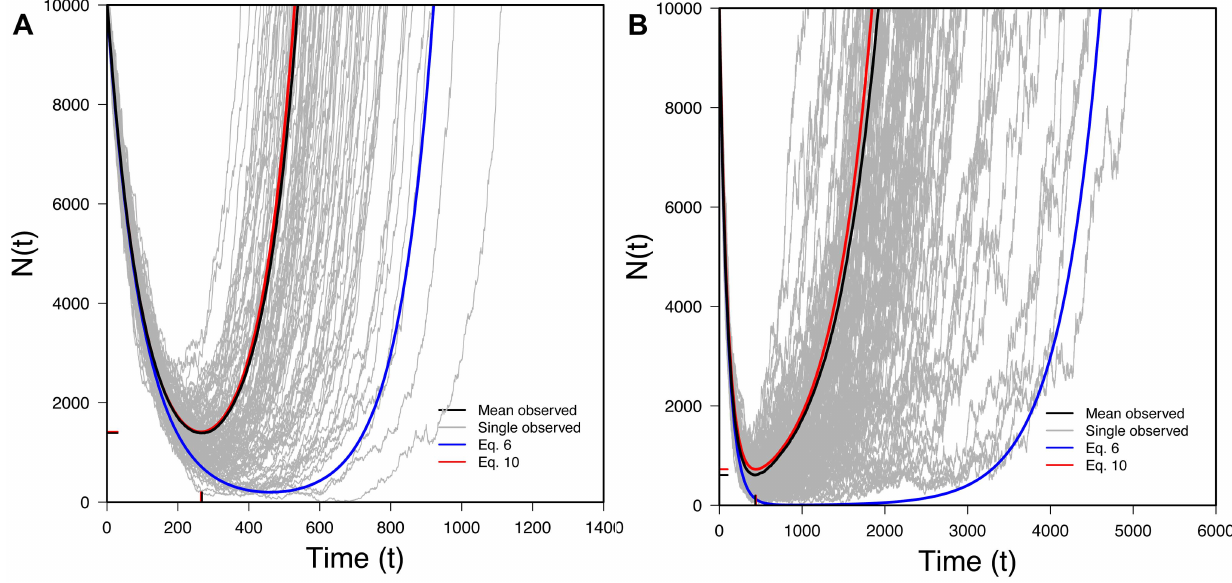
Figure 3. The U-shaped trajectory for populations rescued from standing variation. 100 randomly selected successful realizations in gray, mean of all successful realizations in black, Eq. 6 (without the oversampling correction) in blue, Eq. 10 (with the oversampling correction) in red. Ticks on X-axis represent observed (black) and predicted (red) t min (Eq. 13) while ticks on the Y-axis represents observed (black) and predicted (red) N min (Eq. 14). A) N 0 =10,000, r =0.01, s =0.02, k =1; B) N 0 =100,000, r =0.01, s =0.02, k =1; 100,000 realizations.